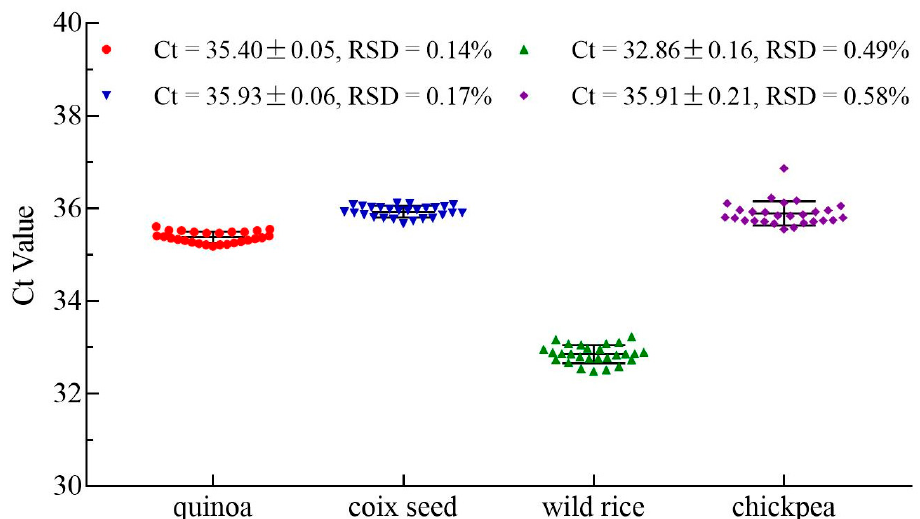
Figure 4. Robustness of quinoa, coix seed, wild rice and chickpea systems. The Ct value ± SD of quinoa was 35.4 ± 0.05, and the RSD was 0.14%; the Ct value of coix seed was 35.93 ± 0.06, and the RSD was 0.17%; the Ct value of wild rice was 32.86 ± 0.16, and the RSD was 0.49%; the Ct value of chickpea was 35.91 ± 0.21, and the RSD was 0.58%.